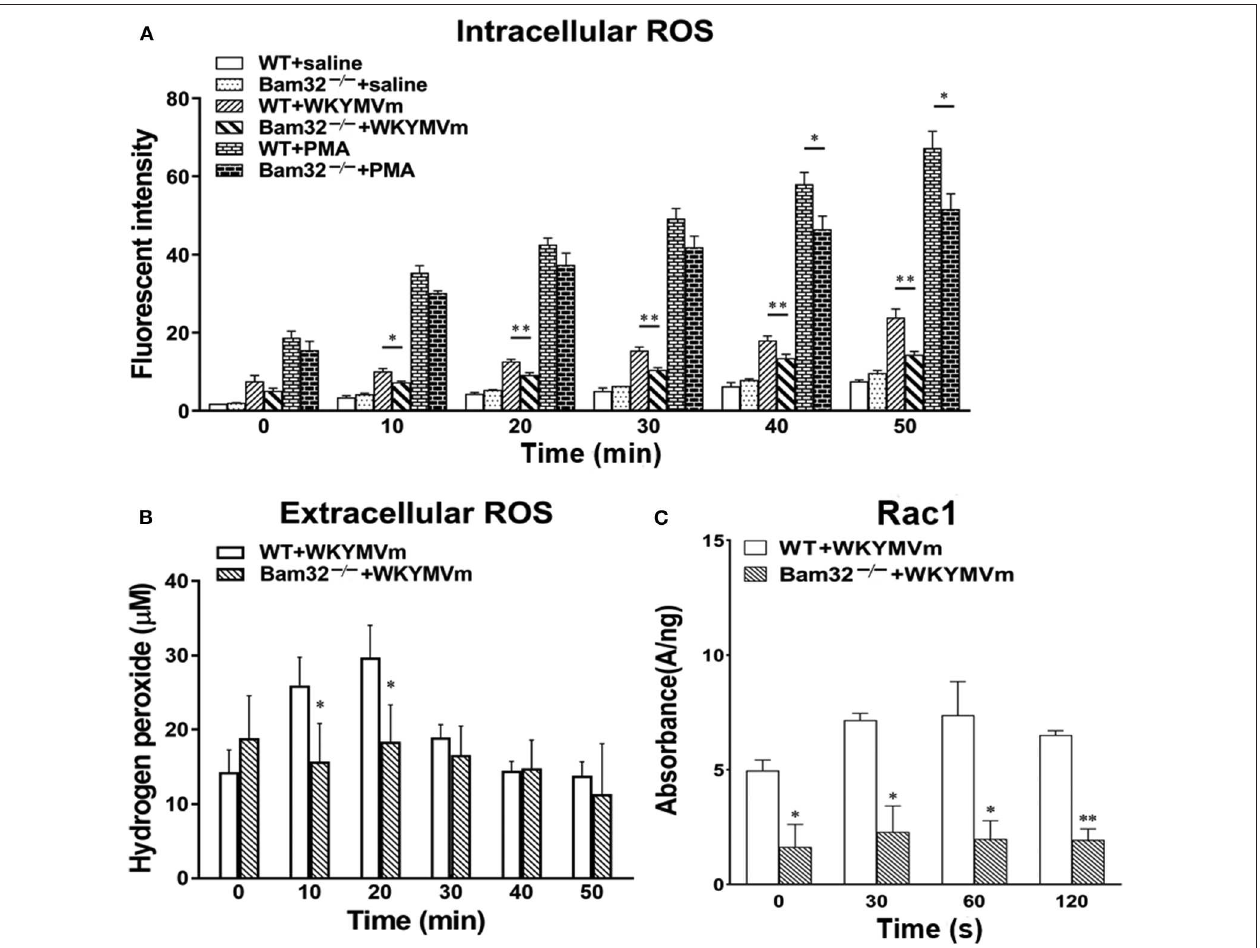
FIGURE 3 | ROS generation and Rac1 activation in bone marrow-derived neutrophils from WT and Bam32 − / − mice. (A) Time course of intracellular generation of ROS in isolated neutrophils with saline, WKYMVm (0.1 µ M) or PMA (0.2 µ M). (B) Time course of extracellular generation of ROS in isolated neutrophils with WKYMVm. (C) Rac1 activation in isolated neutrophils with WKYMVm. (A–C) mean ± SEM, n = 3–4. Significant differences between WT and Bam32 − / − neutrophils (* p < 0.05 and ** p < 0.01). Fluorescent signals at 0min in (A,B) were measured immediately following the addition of saline, WKYMVm or PMA. Fluorescent signals at 0min in (C) were measured in neutrophils without the treatment of